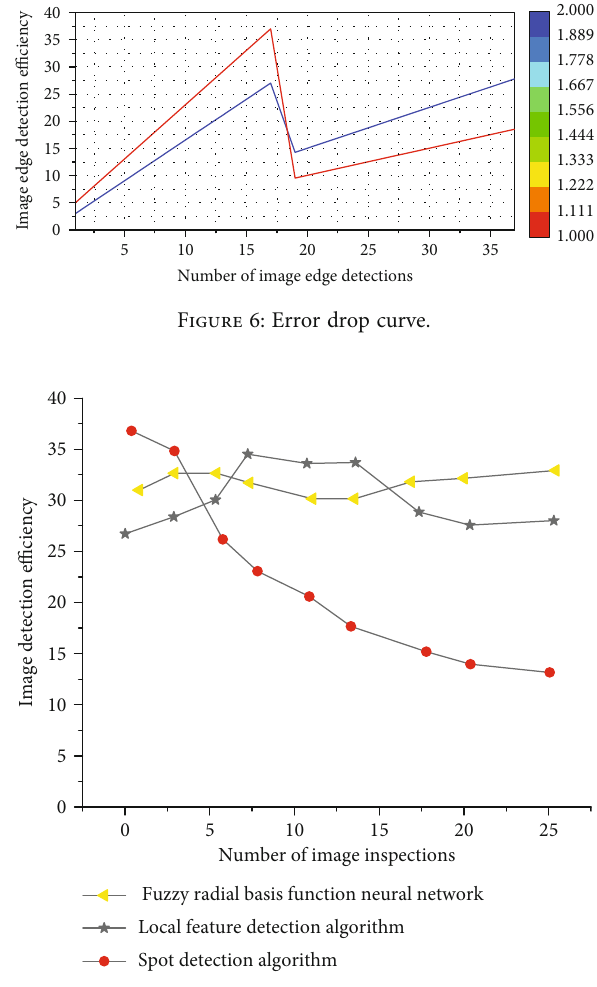
Figure 7: Standard error data